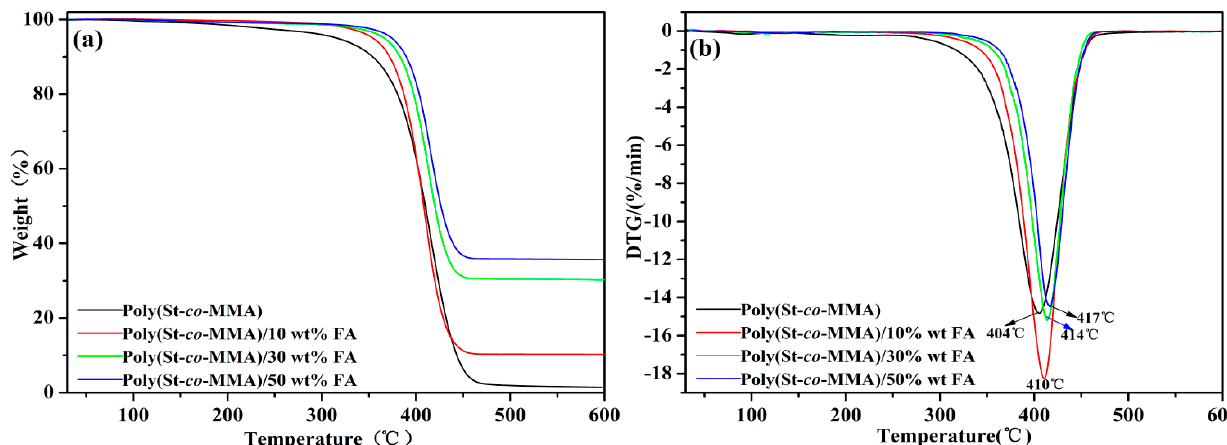
Figure 5. The ( a ) TG and ( b ) DTG curves of (black line) pure poly(St- co -MMA), (red line) 10 wt.% FA, (green line) 30 wt.% FA, and (blue line) 50 wt.% FA microspheres.